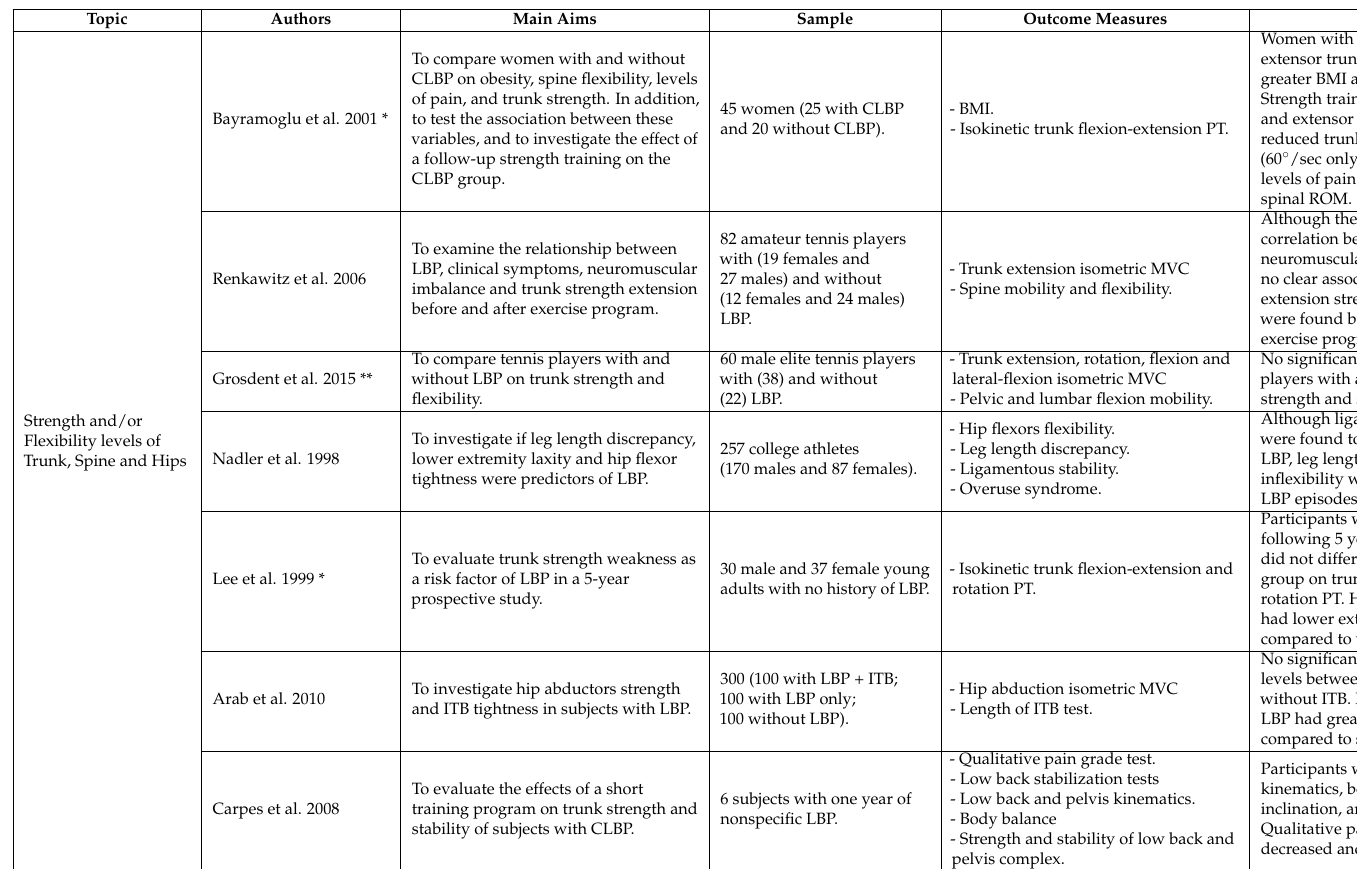
Table 1. Summary of